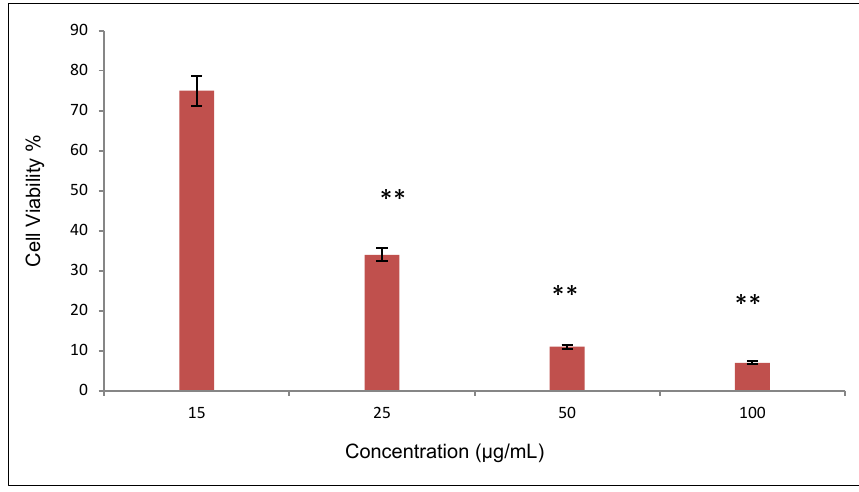
Figure 8. Percentage of live and dead cells calculated from AO/EB staining, ** p < 0.001. Several pathological syndromes, such as liver failure, stroke and heart attack, are associated with the abrupt death of tissue or organs as a result of apoptotic deregulation. In addition, the survival of abnormal cells, due to aberrant apoptosis, may lead to tumorigenesis [19,20]. Apoptosis is commonly altered in cancerous cells, and those cells have the ability to evade the apoptotic cascade. The Ag-NPs synthesized using Achillea biebersteinii extract significantly increased the programmed cell death in the treated MCF-7 cells. Ag-NPs inhibited the proliferation of MCF-7 cells dose and time dependently, which demonstrated that the Ag-NPs prepared using Achillea biebersteinii have great promise as an anti-tumor agent. The findings of this study indicated the potential for Achillea biebersteinii in drug development against